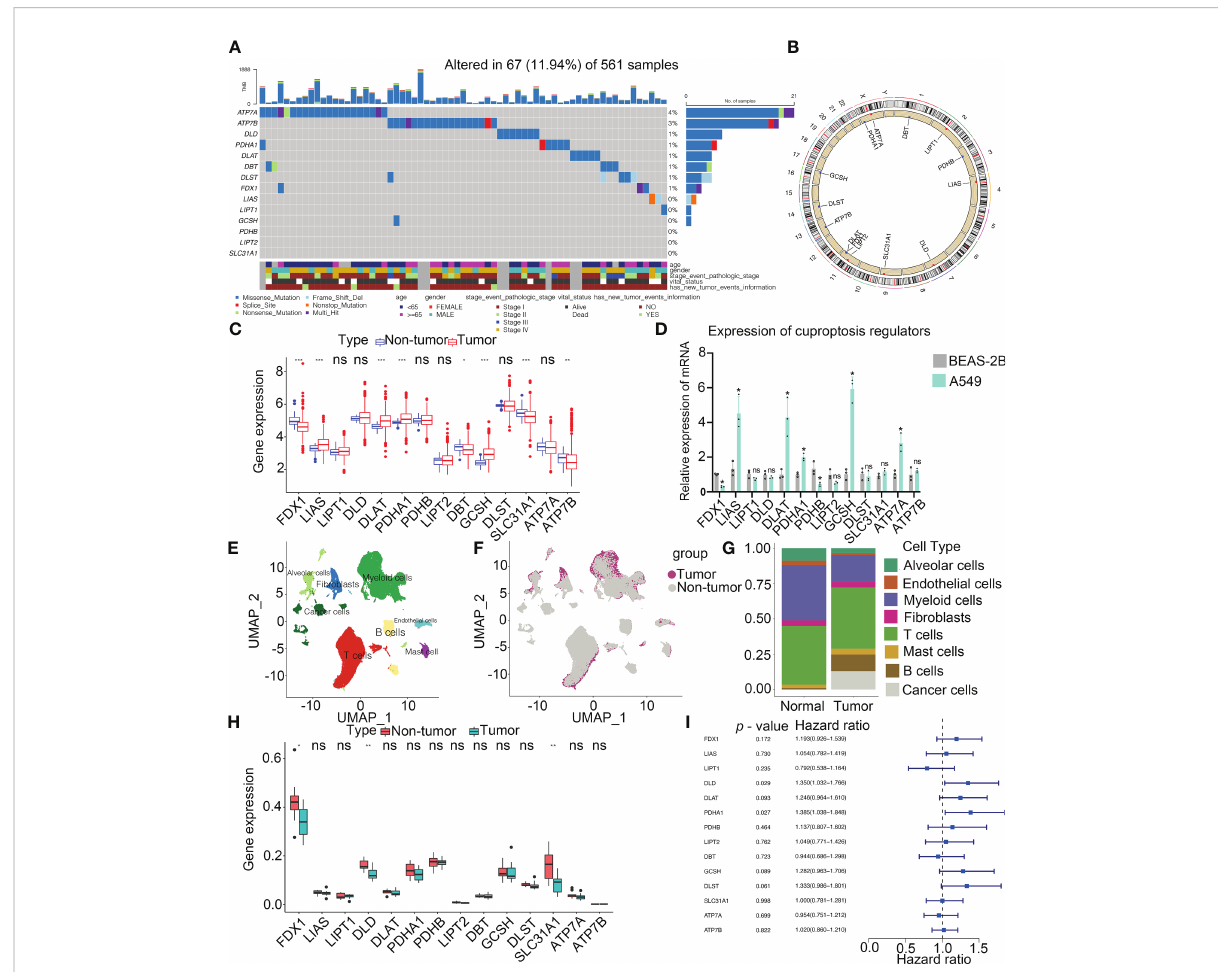
FIGURE 2 Landscape of genetic and expression variation of cuproptosis regulators in LUAD. (A) Mutation frequency of cuproptosis regulators in 561 LUAD patients from the TCGA cohort. Each column represents individual patients. The upper bar graph showed tumor mutational burden. The number on the right indicates the mutation frequency in the regulators. The right bar graph revealed the proportion of each variant type. The graph below determined clinical features of patients in the cohort. (B) Location of CNV alteration of cuproptosis regulators on 23 chromosomes. (C) Bulk sequencing showed the expression of cuproptosis regulators between adjacent non-tumor and LUAD samples in TCGA-LUAD cohort (n = 585). (D) Expression of cuproptosis regulators in NSCLC (A549) and normal lung epithelial cell line (BEAS-2B) by RT- PCR. (E) UMAP indicated the cell composition in the microenvironment of LUAD according to cell types. (F) Cell distribution originated from tumor and normal lung samples. (G) Bar plot determined the overall cell composition of normal and tumor samples. (H) ScRNA-seq analysis revealed the expression of cuproptosis regulators between adjacent non-tumor and LUAD samples in GSE131907 cohort (n = 22). (I) Forest plot showed the prognosis of cuproptosis regulators for LUAD patients in TCGA (n = 585). UMAP, uniform manifold approximation and projection. * p < 0.05, ** p < 0.01, *** p < 0.001, ns, not signi fi